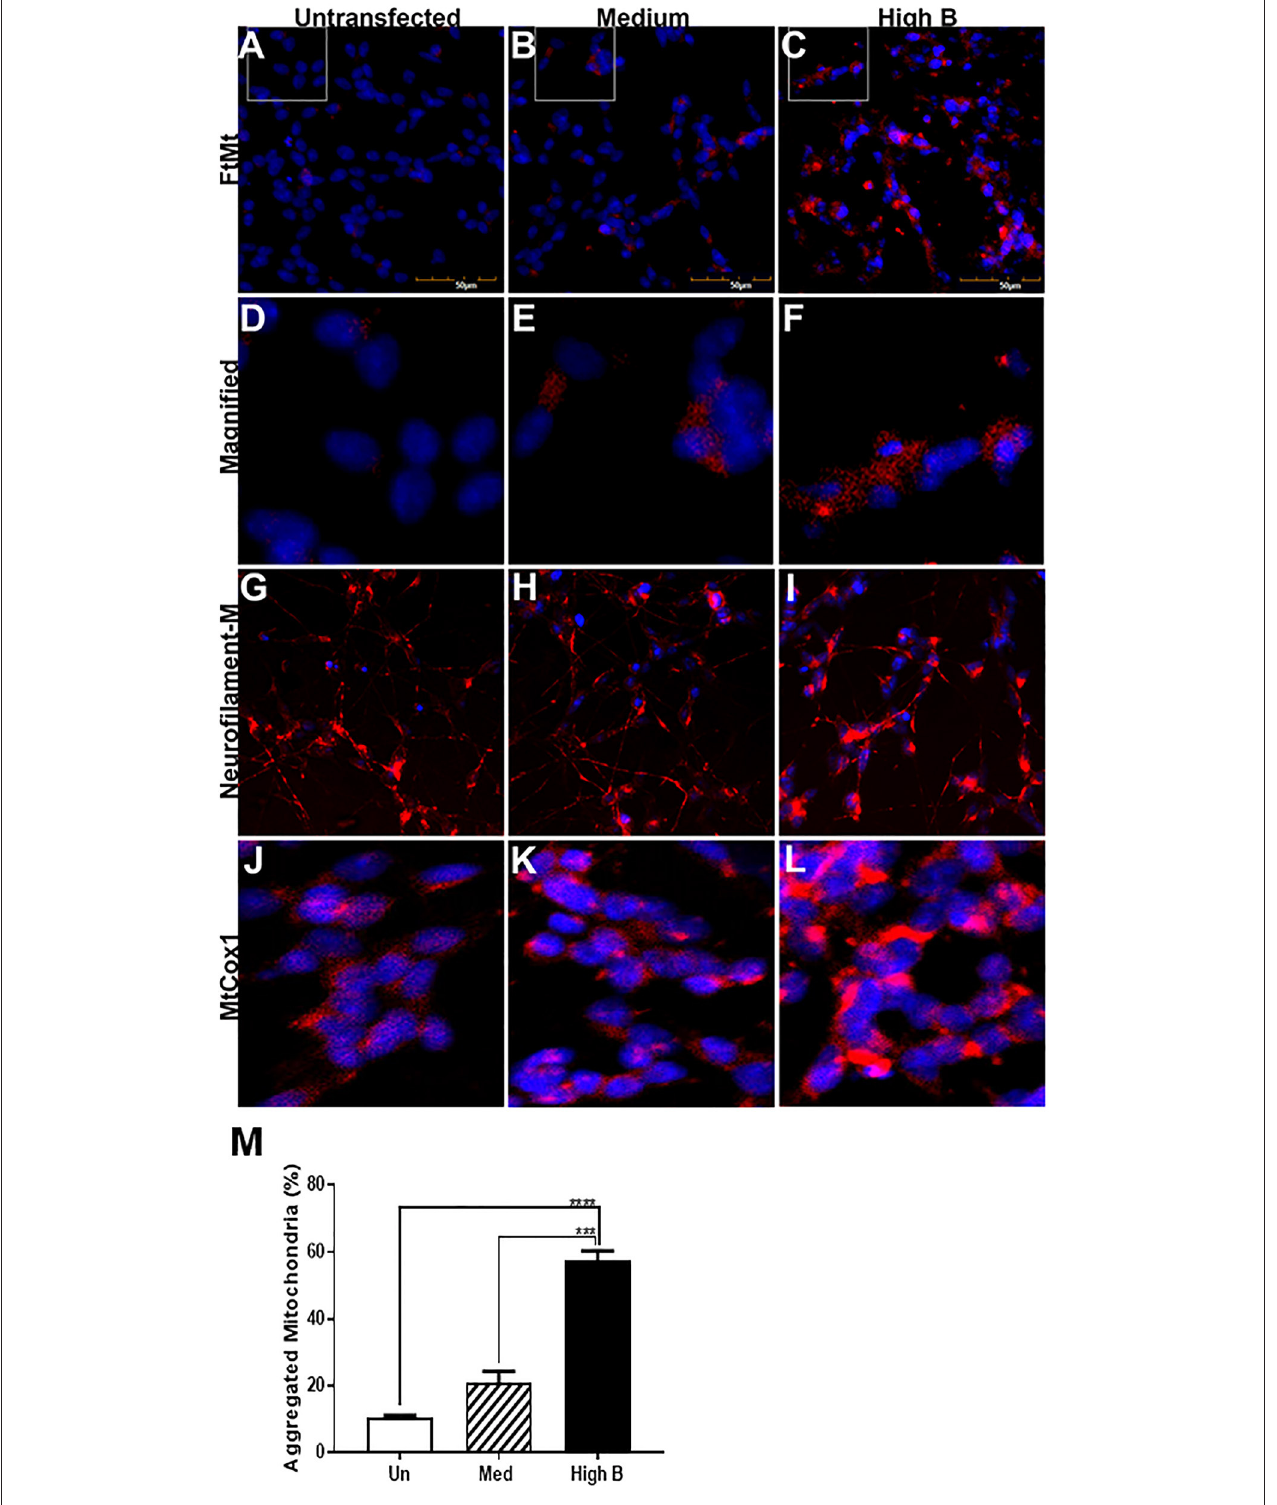
FIGURE 2 | Immunocytochemistry of FtMt expressing clones. (A–C) . Untransfected (A) , Medium (B) , and High B (C) clones differentiated for 7 days stained with antibody to FtMt to identify positive expressing cells. Positive staining is observed for Medium and High B clone, but not untransfected cells. Antibody reacted cells were identified by reaction with Alexa568 labeled-anti rabbit immunoglobulin G. All images were recorded using an Olympus FV1000 laser